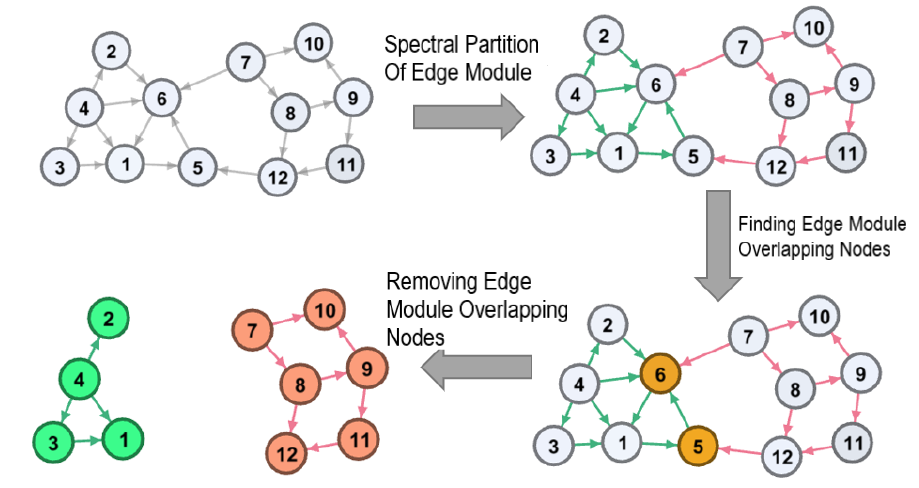
Figure 1. Directed network disassembly flow